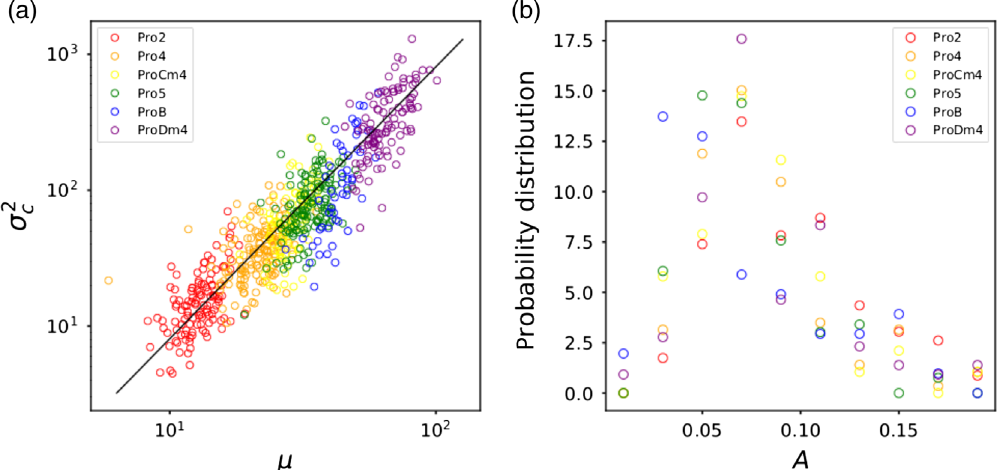
FIG. 10. Taylor ’ s law in strains with chromosomal integrated promoters. (a) Variance as a function of the mean for fluorescence data in which constitutive promoters from the same family of promoters used in the current study are integrated in the chromosome. The prefactor determined from the data for individual mother cells is found to lie in the range A ¼ 0 . 083 (cid:2) 0 . 046 . The slope of the black line = μ 2 for different promoters. No statistically significant correlation between A and μ is found is 2. (b) Distributions of the prefactor A ≡ σ 2 c − 0 . 07 , which is consistent with experiments using plasmids. Data taken from Ref. with C A μ ¼